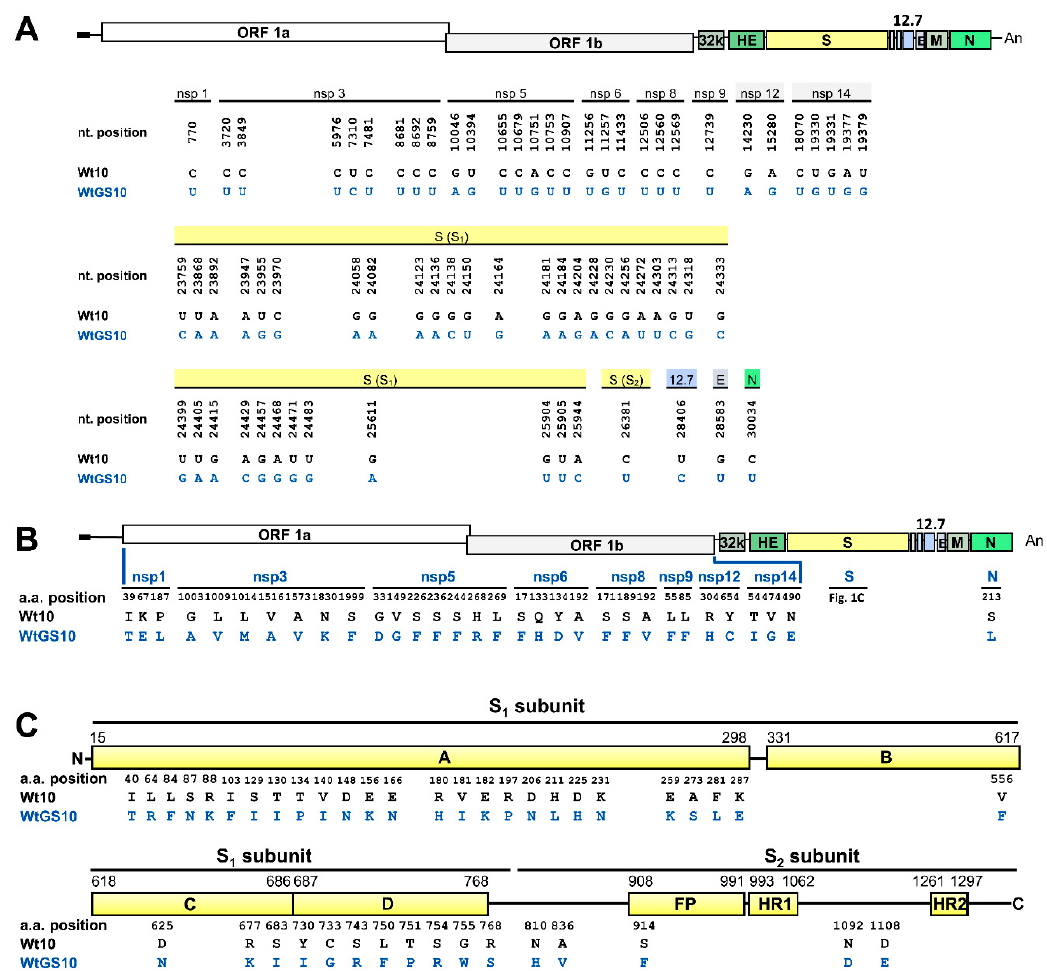
Figure 1. Linear schematic of BCoV genome showing the location of mutated nt and aa under the treatment of GS-5734 in HRT-18 cells. ( A ) Linear schematic of BCoV genome showing the comparison of the nt sequences identified from HRT-18 cells infected with wt BCoV (Wt) in the presence (WtGS10) or absence (Wt10) of GS-5734 at VP10. ( B ) Linear schematic of BCoV genome showing the comparison of the aa sequences identified from HRT-18 cells infected with Wt in the presence (WtGS10) or absence (Wt10) of GS-5734 at VP10. ( C ) Linear schematic of BCoV S protein with subunits S1 (domains A–D) and S2 (FP, HR1, and HR2) showing the positions of the aa alterations identified from HRT-18 cells infected with Wt in the presence (WtGS10) or absence (Wt10) of GS-5734 at VP10. The residue numbering is based on the BCoV Mebus strain spike protein (GenBank: U00735) with domain boundaries based on the HCoV-OC43 S structure, Adapted from Hulswit, R.J.G.; Lang, Y.F.; Bakkers, M.J.G.; Li, W.T.; Li,